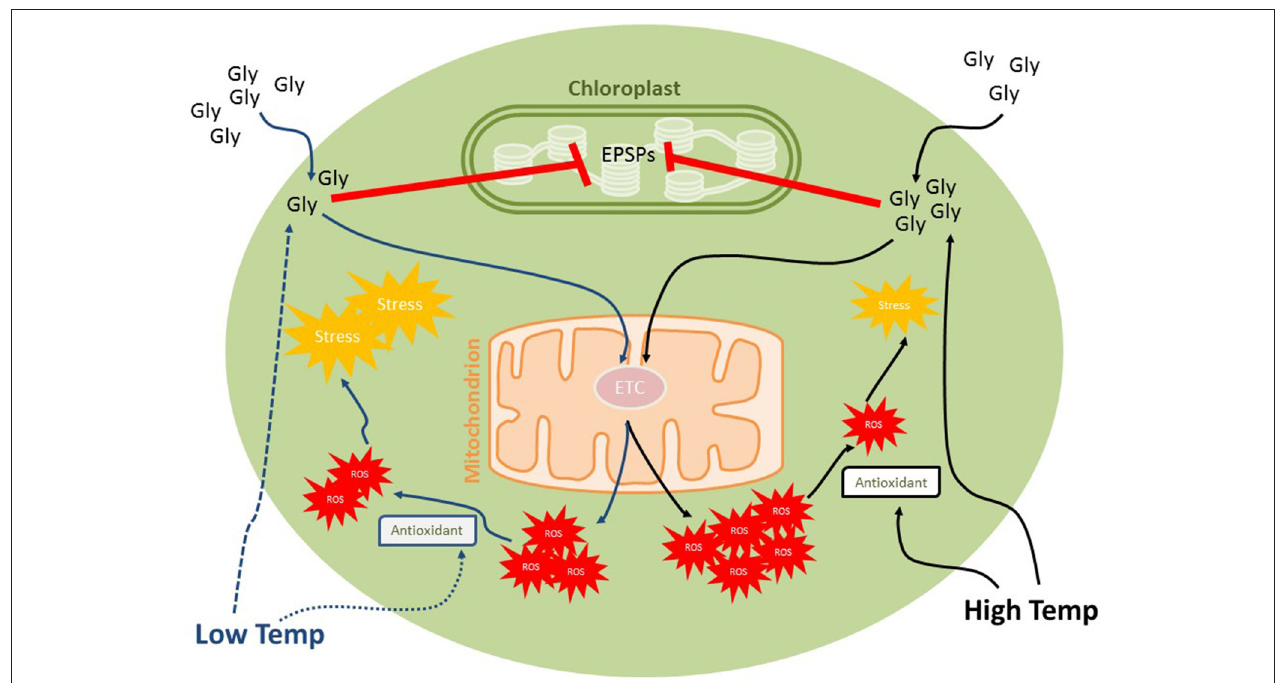
FIGURE 2 | Effects of low temperature and high physiological temperatures on the toxic effects of glyphosate on phytoplankton. Glyphosate herbicidal effects are due the inhibition of 5-enolpyruvylshikimate-3-phosphate (EPSP) synthase activity in chloroplast but it is also known to block mitochondrial electron transport chain, inducing reactive oxygen species (ROS) formation. Low temperature decrease both glyphosate uptake (by modulating membrane permeability) and antioxidant activities, the contrast being expected under increased temperatures. Although increasing glyphosate uptake, respiration activity and ROS formation, higher temperatures can induce antioxidant activities, decreasing potential oxidative damages from ROS